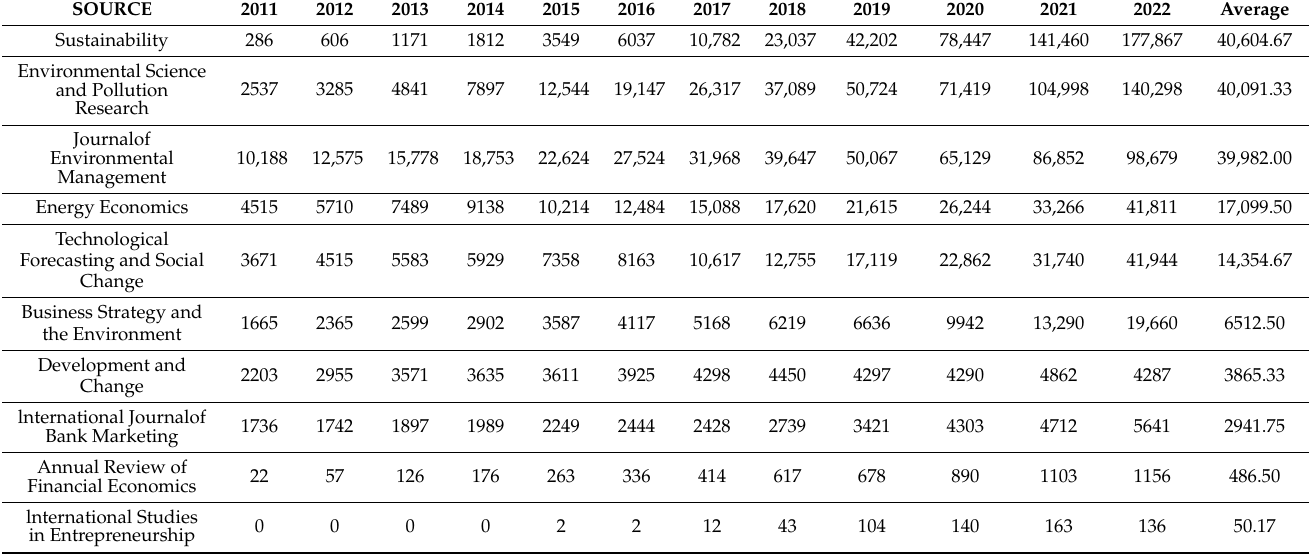
Table 4. Citations received per source.